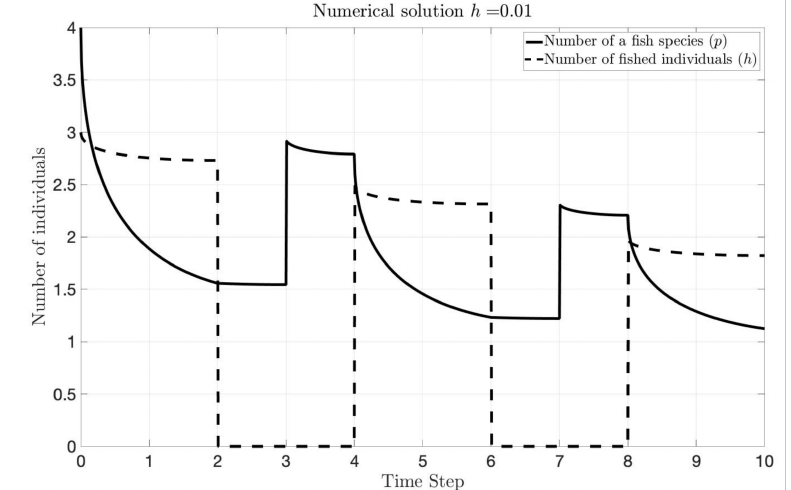
Figure 6. Numerical approximation of System (127). The continuous line represents the fish population ( p ) and the discontinuous one the number of fished individuals ( h